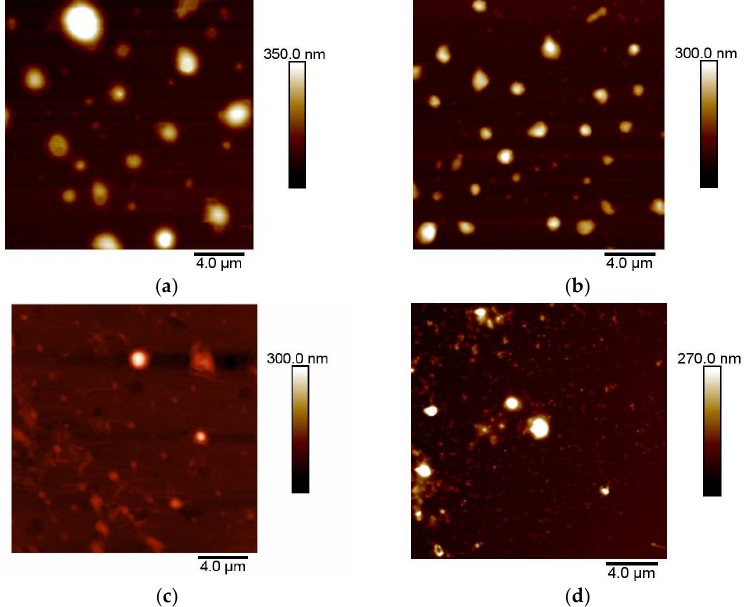
Figure 1. Microscopic images using AFM. ( a ) uncoated niosomes (Nio); ( b ) uncoated niosomes with pentamidine (NioP); ( c ) chitosan glutamate coated niosomes (CG-Nio); ( d ) chitosan glutamate coated niosomes with pentamidine